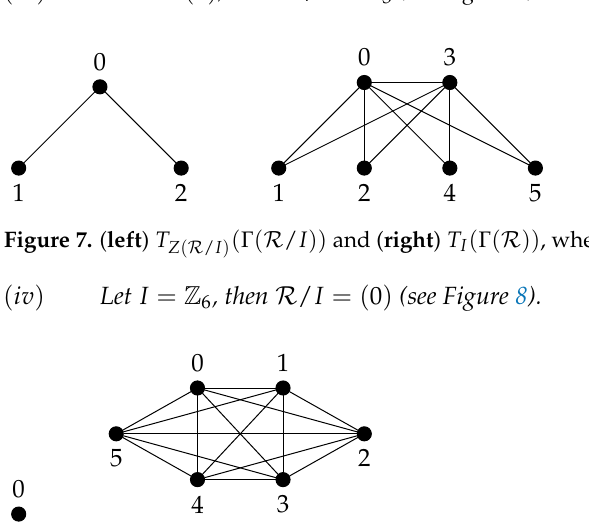
Figure 6. ( left ) T Z ( R / I ) ( Γ ( R / I )) and ( right ) T I ( Γ ( R )) , when R = Z 6 and I = ( 2 ) . ( iii ) Let I = ( 3 ) , then R / I = Z 3 (see Figure 7).